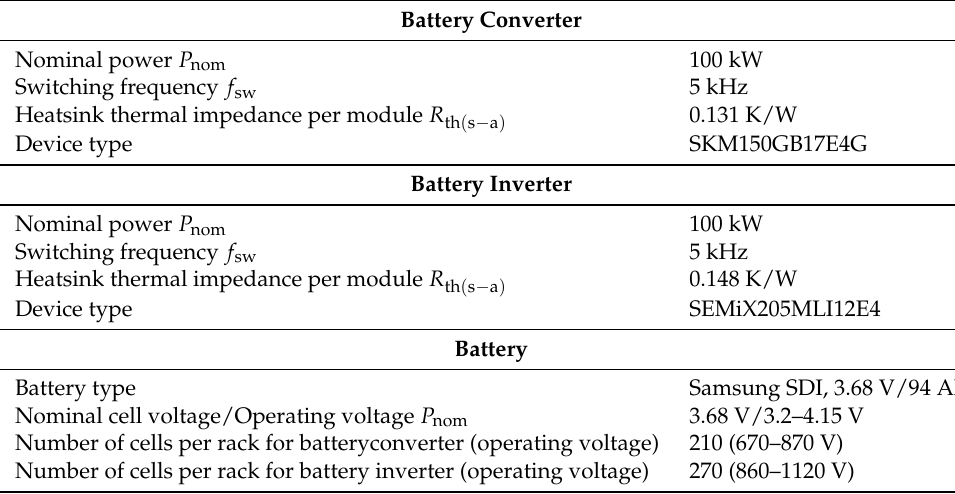
Figure 7. Battery energy storage system: ( a ) for the DC-coupled configuration and ( b ) for the AC-coupled configuration (PCC: the point of common coupling). Table 2. BESS